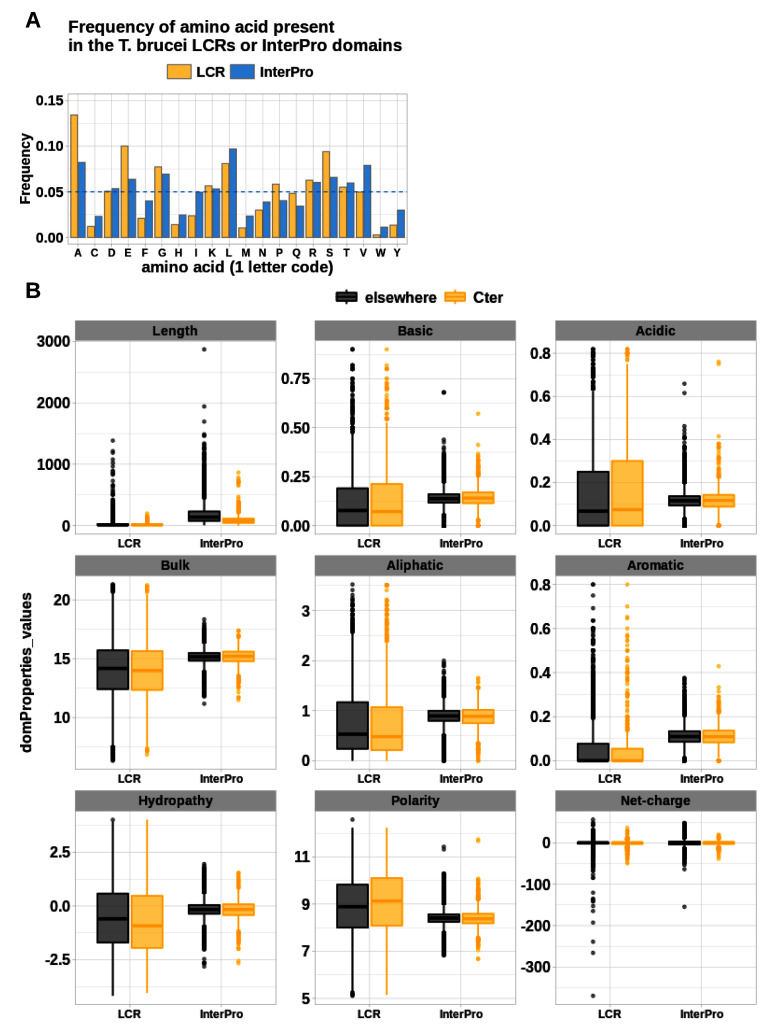
Amino acid composition and properties of low-complexity regions (LCRs).
A) Frequency of each amino acid in LCRs (yellow) and InterPro domains (blue). Amino acids are indicated with the one letter code and the 1/20th value represented by the blue dashed line to indicate over- or under-representation as an average.
B) The amino-acid sequence properties (Alkazam R package
12) of LCRs and InterPro domains were analysed according to their localisation in the C-terminal region (yellow) or elsewhere (grey) on the proteins. Nine properties were analysed: acid, aliphatic, aromatic, base, bulkiness, net-charge, hydropathy, length and polarity indices.